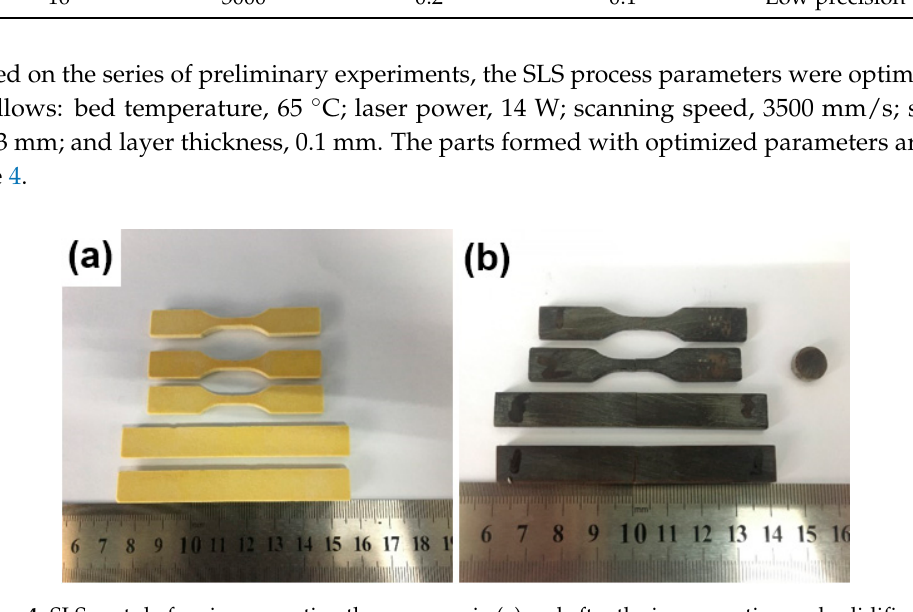
Figure 4. SLS parts before impregnating the epoxy resin ( a ) and after the impregnating and solidification ( b